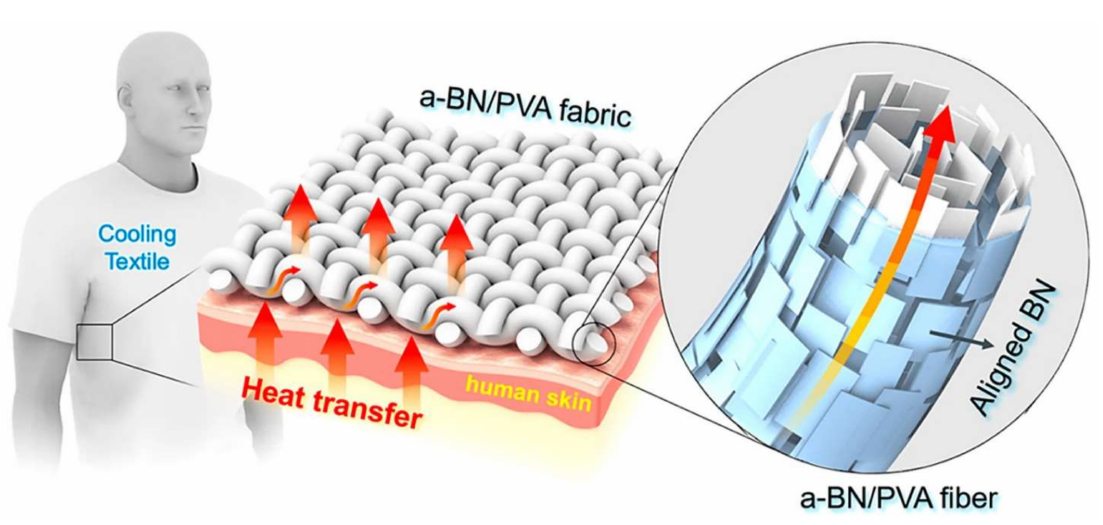
Figure 8. Graphic presentation of the thermal regulation textile. The textile is composed of thermally conductive composite fibers with well-aligned and interconnected BN nanosheets embedded in the PVA polymer matrix. Reprinted with permission from [97]. Copyright (2017) American Chemical